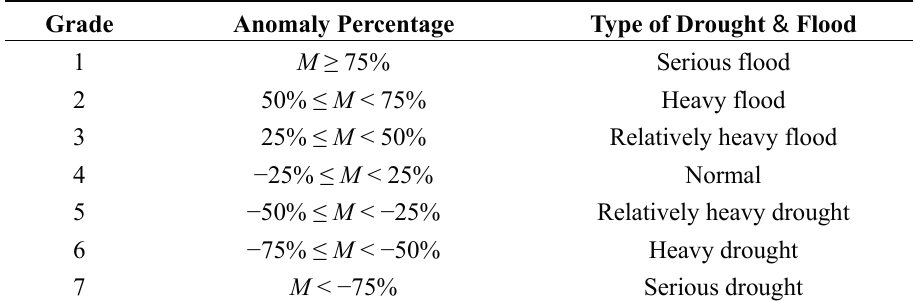
Table 9. Drought & flood grade standard of precipitation anomaly percentage ( M